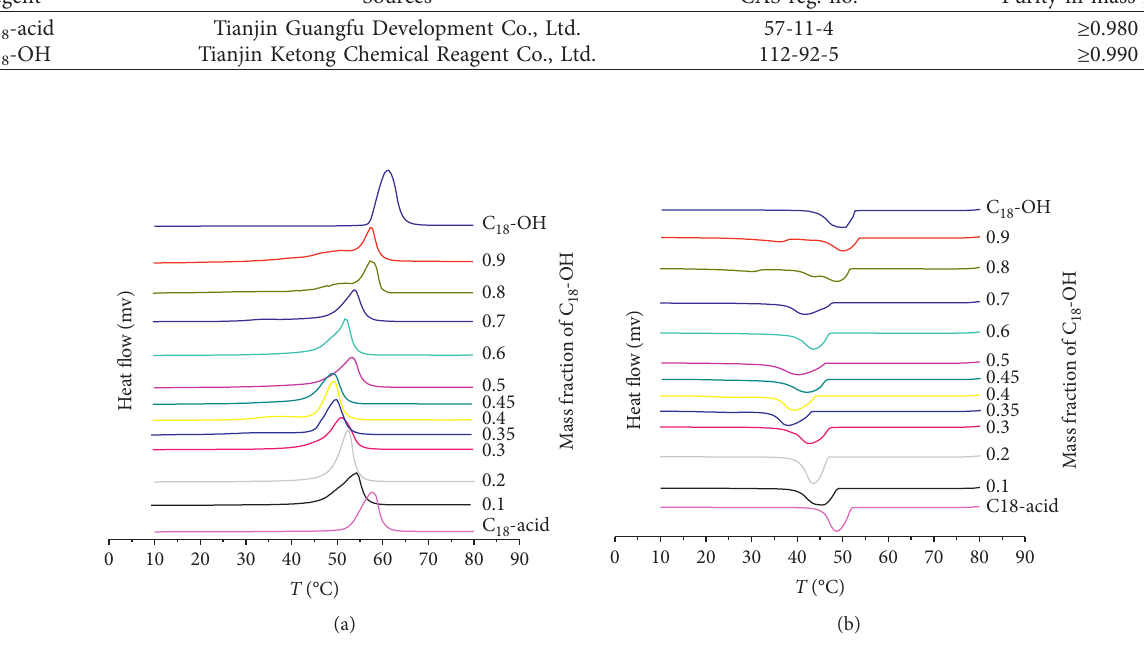
Figure 1: Comparison of heating (a) and cooling (b) DSC curves of the binary system of C